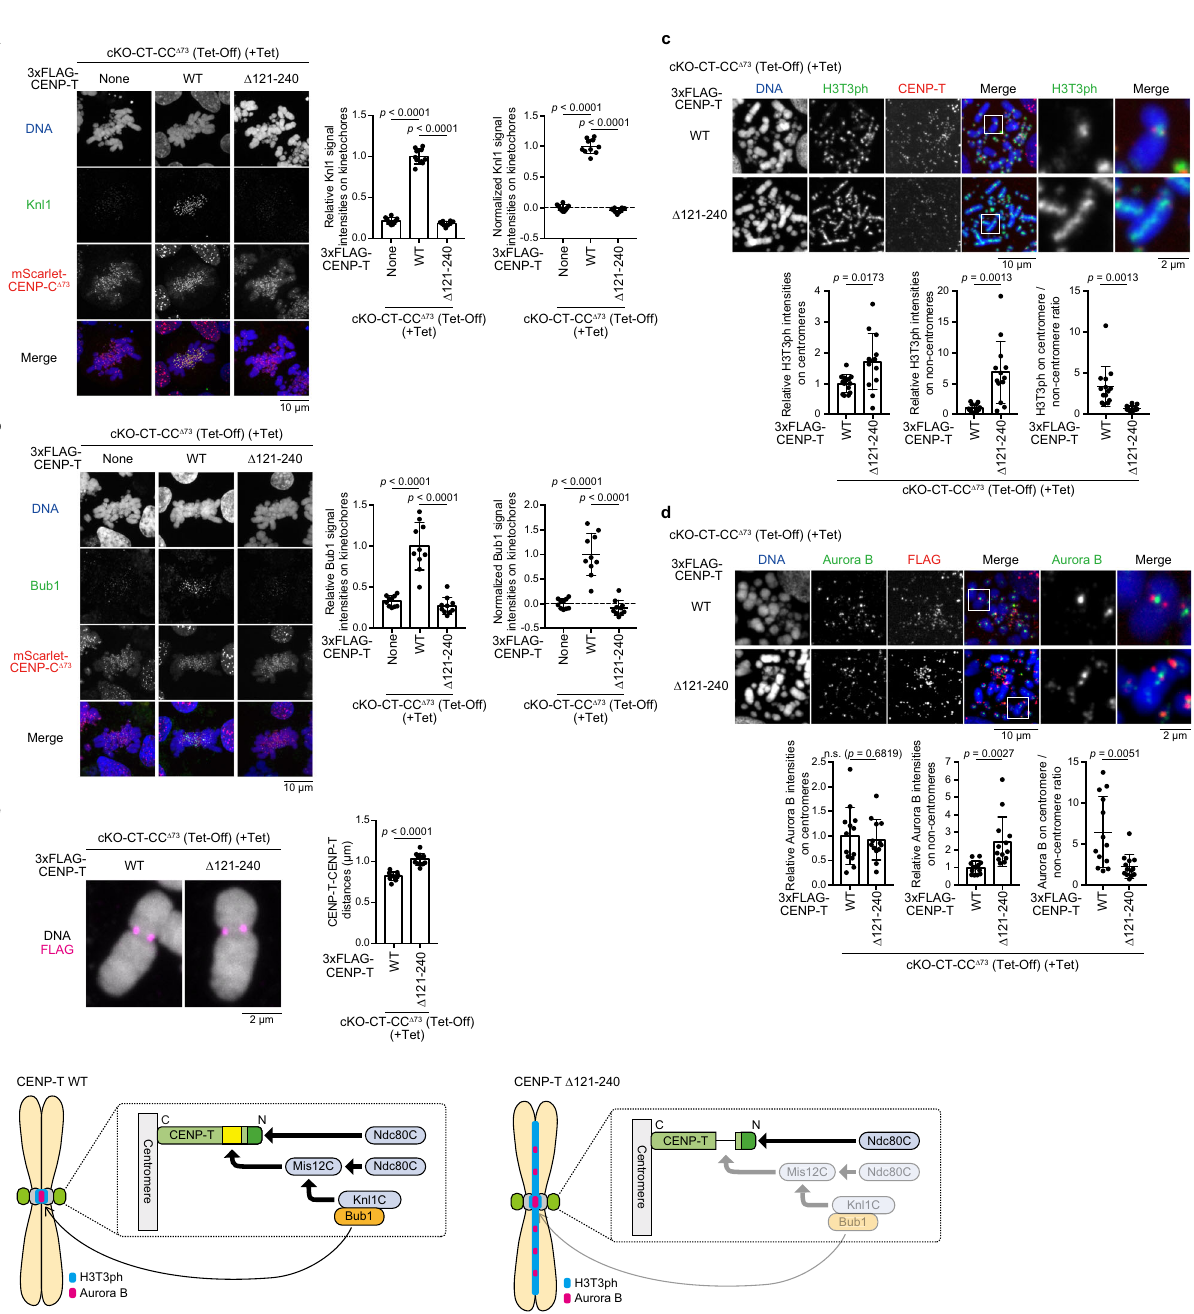
Fig. 3 Reduction of Knl1C levels and sister chromatid cohesion defects in cells lacking the CENP-T-Mis12C interaction. a Knl1 levels at kinetochores in cKO-CENP-T cells expressing mScarlet-CENP-C Δ 73 and either CENP-T WT or CENP-T Δ 121-240 in the presence of Tet for 30 h. None indicates parental cKO- CENP-T/CENP-C Δ 73 cells. Subtract values are presented using signal intensities of None. DNA was stained with DAPI. Error bars indicate the mean and standard deviation. p values were calculated by one-way ANOVA followed by Tukey ’ s test. b Bub1 levels at kinetochores in cKO-CENP-T cells expressing mScarlet-CENP-C Δ 73 and either CENP-T WT or CENP-T Δ 121-240 in the presence of Tet for 30 h. None indicates parental cKO-CENP-T/CENP-C Δ 73 cells. Subtract values with None are presented. DNA was stained with DAPI. Error bars indicate the mean and standard deviation. p values were calculated as in a . c Immuno-localization of H3T3ph on chromosomes in cKO-CENP-T cells expressing mScarlet-CENP-C Δ 73 and either CENP-T WT or CENP-T Δ 121-240 in the presence of Tet for 30 h and nocodazole for last 4 h. The insets show magni fi ed views of the boxed regions. Graphs summarize H3T3ph localization pro fi les on centromeres or non-centromeres. Error bars show the mean and standard deviation. p values were calculated by two-tailed Welch ’ s t -test. d Immuno-localization of Aurora B on chromosomes in cKO-CENP-T cells expressing mScarlet-CENP-C Δ 73 and either CENP-T WT or CENP-T Δ 121-240 in the presence of Tet for 30 h and nocodazole for last 4 h. The insets present magni fi ed views. Graphs summarize Aurora B localization pro fi les on centromeres or non-centromeres. Error bars show the mean and standard deviation. p values were calculated as in c . e Kinetochore-kinetochore distances of mitotic chromosomes in cKO-CENP-T cells expressing mScarlet-CENP-C Δ 73 and either CENP-T WT or CENP-T Δ 121-240 in the presence of Tet for 30 h and nocodazole for last 4 h. Error bars indicate the mean and standard deviation. p values were calculated as in c . f Mis12C and Knl1C (KM) on the CENP-T pathway function for the maintenance of sister chromatid cohesion (left). When KM is absent from CENP-T (right), H3T3ph and Aurora B are diffused into non-centromere regions, causing defects in sister chromatid